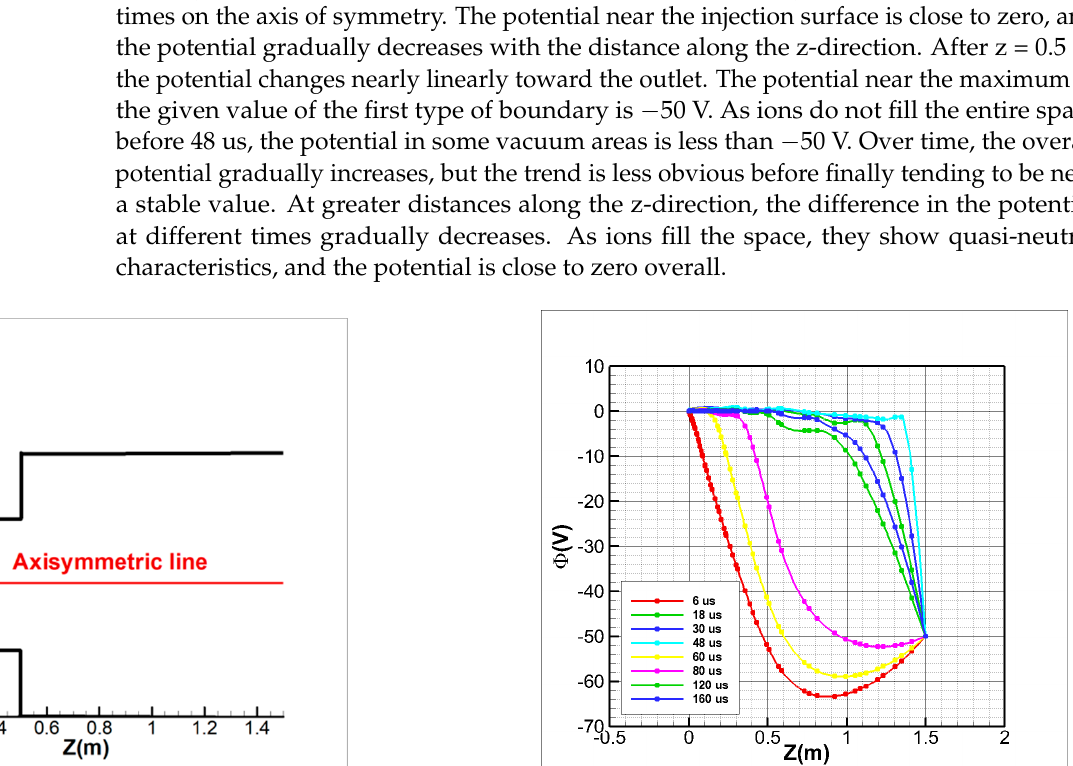
Figure 6. Potential distribution at different times on the x = 0 plane.